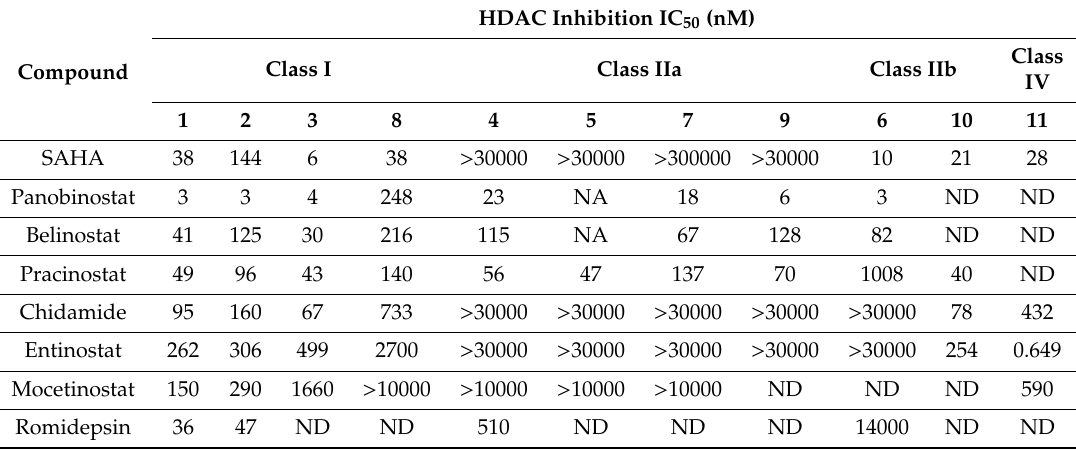
Table 3. IC 50 values of HDAC inhibition